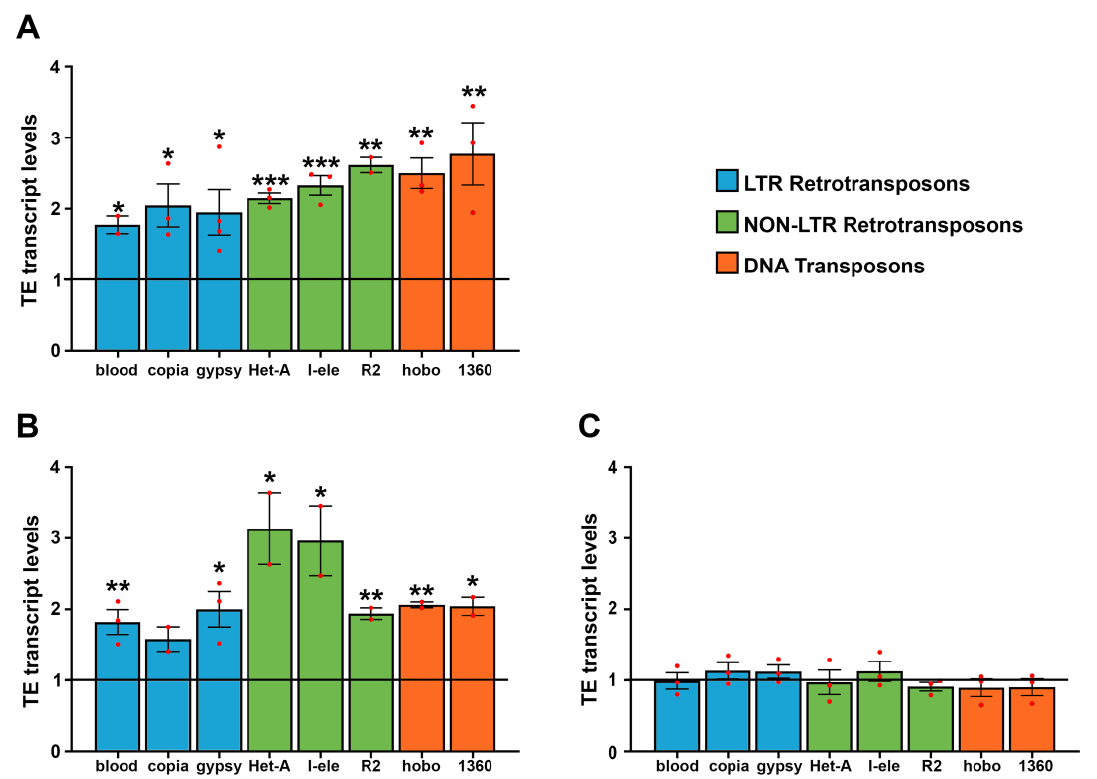
Figure 1. qRT-PCR analysis of transposable element expression in adult heads ( A ), ovaries ( B ) and testes ( C ) from control and WiFi-exposed 10 days-old flies. Transcript levels were normalized to rp49 and displayed as fold change relative to the controls. Bar graph represents the mean ± SEM from at least two independent experiments (* p ≤ 0.05, ** p ≤ 0.01, *** p ≤ 0.001; Unpaired t tests). Red dots indicate individual data points. The black horizontal line indicates the fold change control value, set to 1.